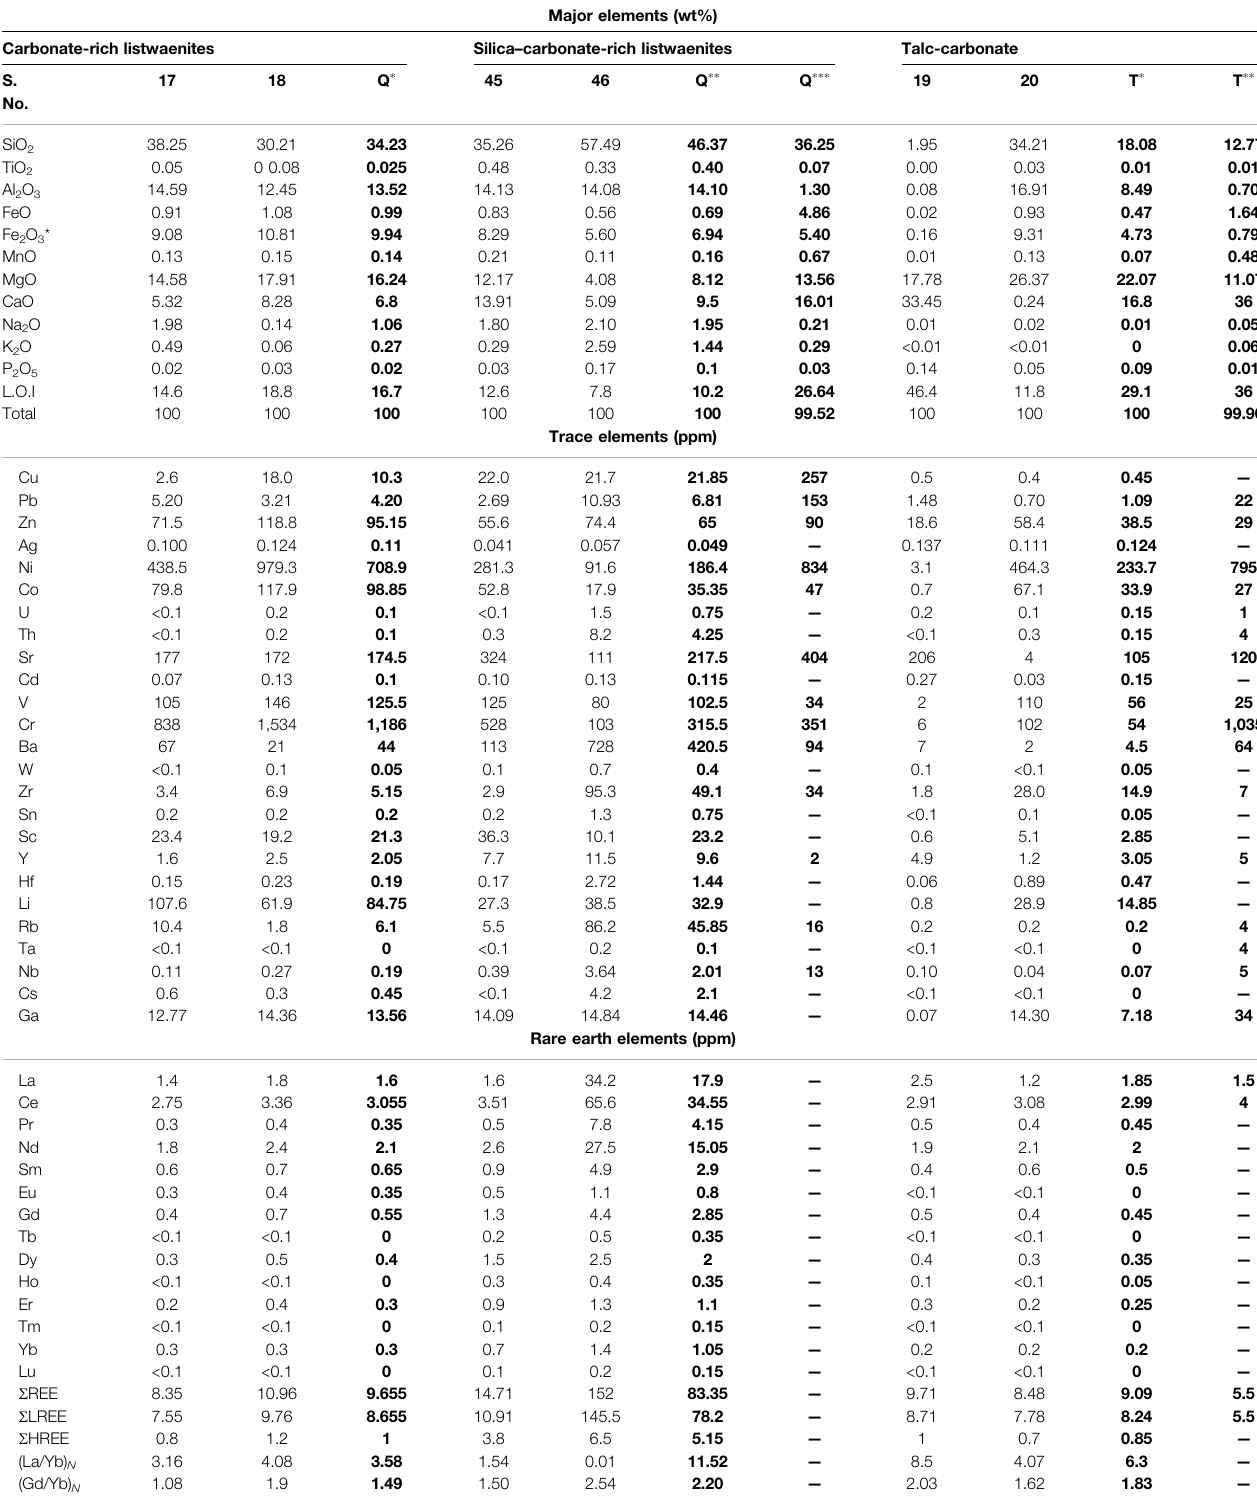
TABLE 2 | Chemical composition of listwaenites and talc-carbonate